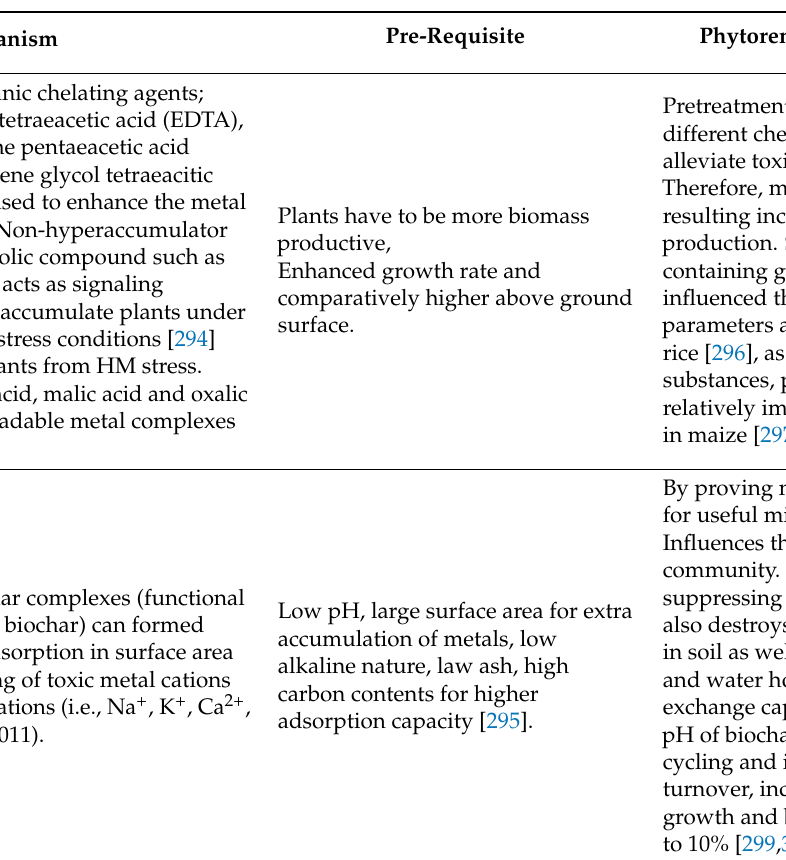
Table 5. Different artificial remediation